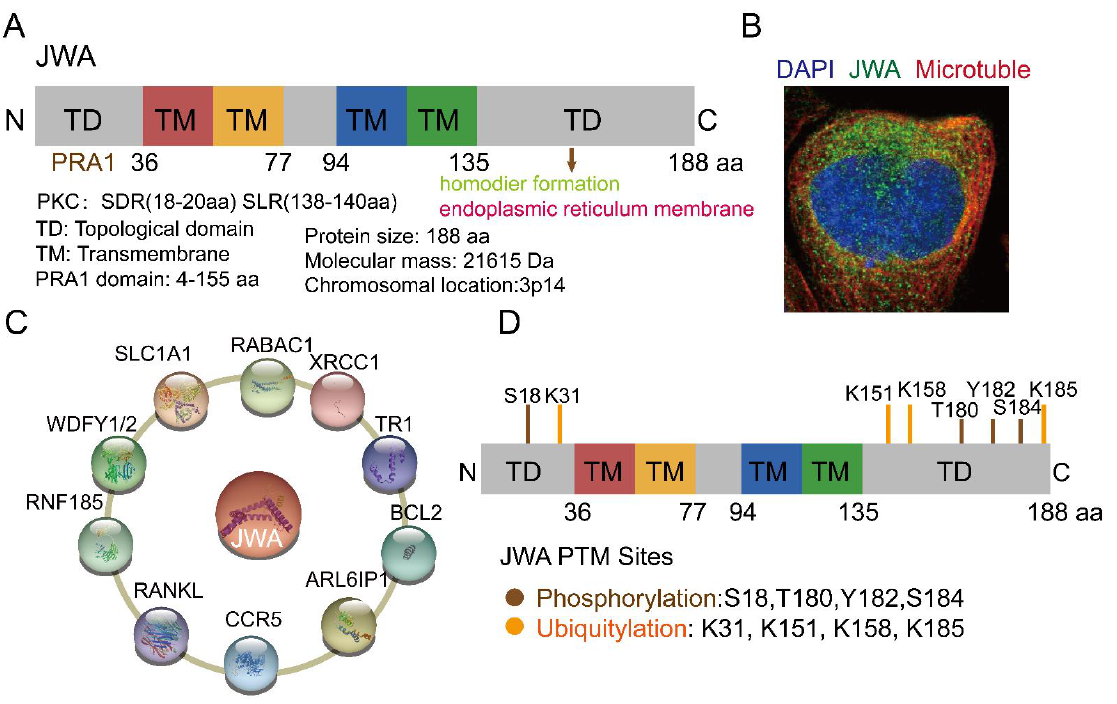
Figure 1. Structure, location and potential modification sites of JWA. ( A ) Domain structure of JWA consists of four transmembrane (TM) domains, two topological domains (TD) in N terminal